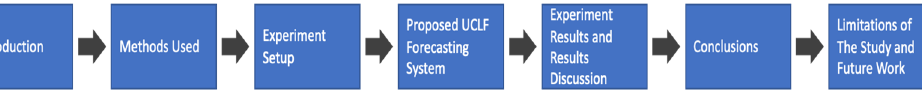
Figure 1. The paper arrangement flow chart.